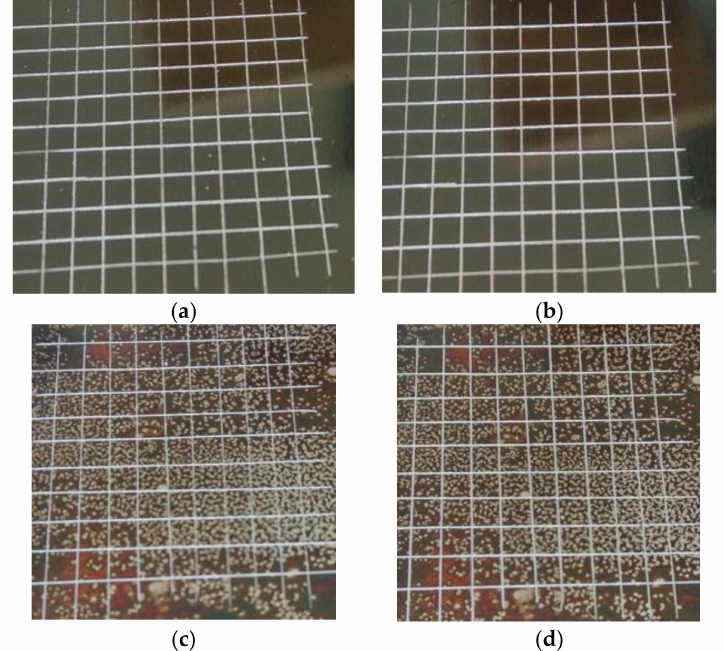
Figure 23. Cross-cut test according to NF EN ISO 2409 of glucose-based and sucrose-based surface coatings on stainless steel cured for 3 min at 300 ◦ C. ( a ) A2 before washing in hot water; ( b ) A2 after washing in hot water; ( c ) B2 before washing in hot water; and ( d ) B2 after washing in hot